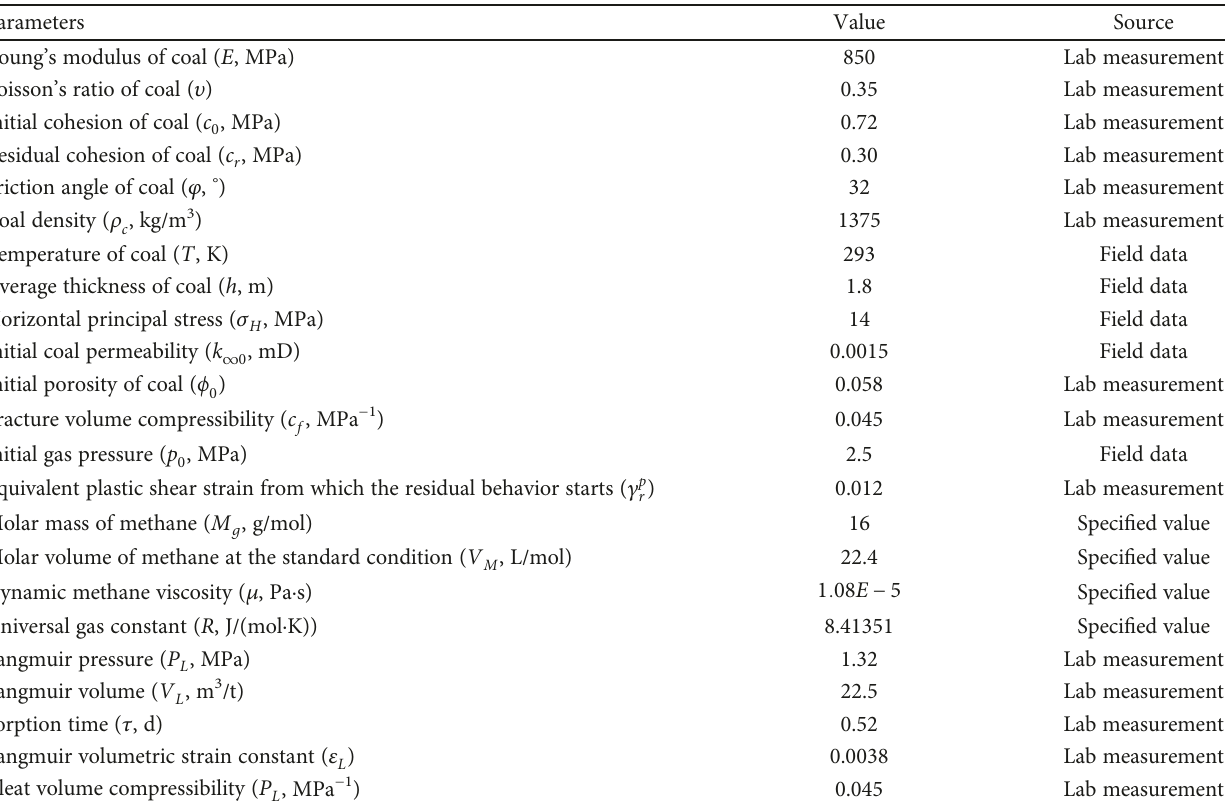
Figure 5: Geometry and boundary conditions for the simulation model. Table 2: Property parameters used in the simulation